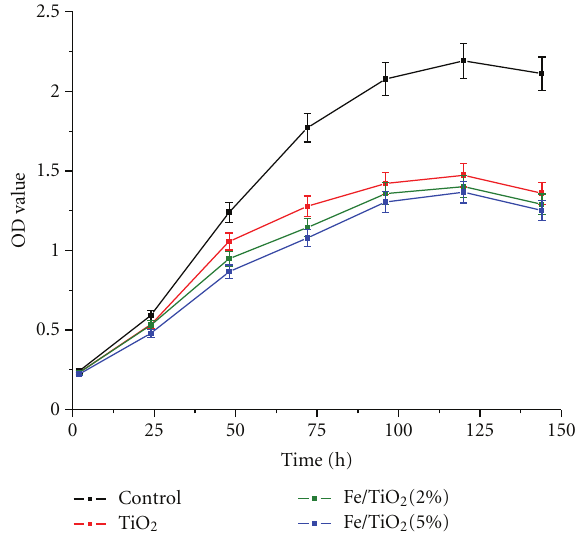
Figure 6: The influence of di ff erent nanoparticles on the prolif- eration of HL60 cells. Data represent the means ± S.D. (standard deviation) from five independent experiments. ∗ P < 0 . 05 as compared to control (untreated) cells.